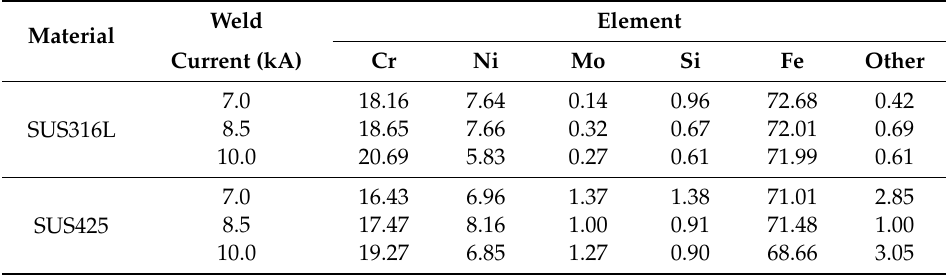
Table 7. EDS chemical composition of welded specimens (i.e., fusion zone) given a 25-cycle welding time